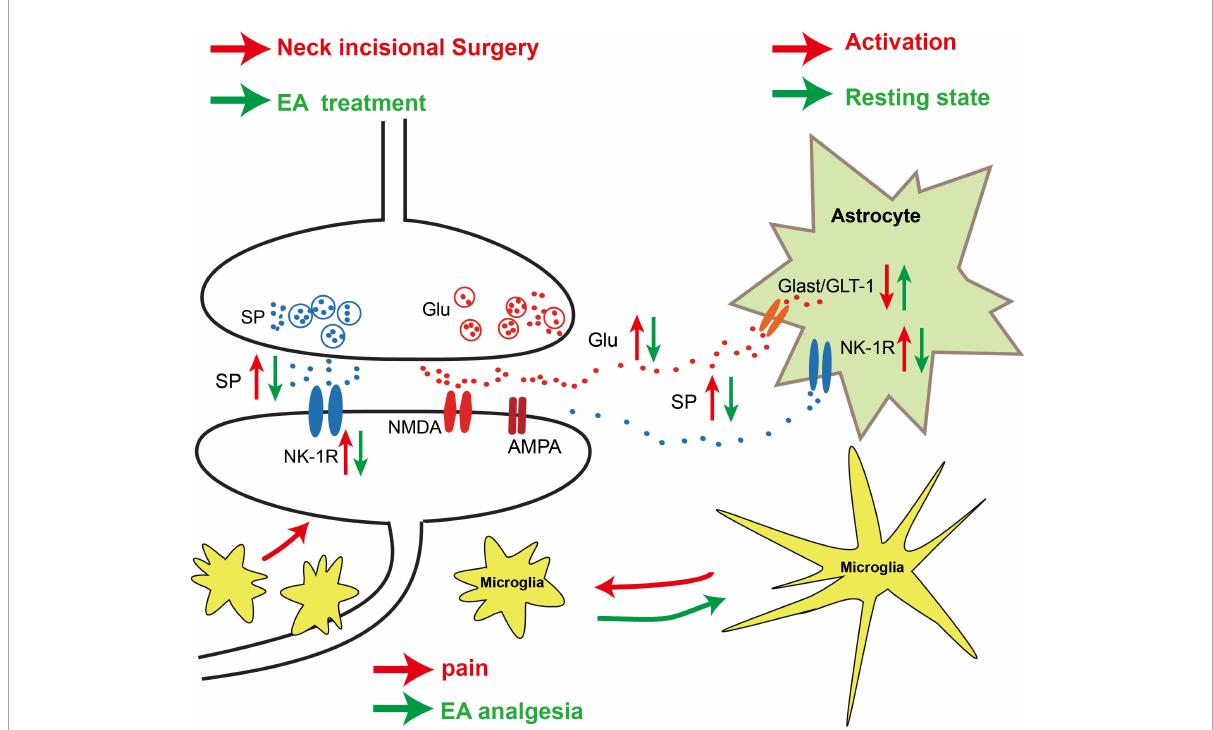
FIGURE10 Schematic diagram showing the neuronal–glial mechanism of electroacupuncture (EA) analgesia in DHs of the cervical spinal cord in rats with incisional neck pain. Following neck incision, more substance P (SP) and glutamate (Glu) were released from the presynaptic terminals of the activated primary afferent nerve fibers in the superficial layers, and more neurokinin-1 receptor (NK-1R) was expressed on the post-synaptic membrane of the neurons and astrocytes. The expression levels of glu aspartate transporter (GLAST)/glu transporter-1 (GLT-1) on astrocytes were decreased, and more extracellular Glu acted on N -methyl- D -aspartate (NMDA)/amino-3-hydroxy-5-methyl-4-isoxazolepropionic acid (AMPA) of the post-synaptic neurons after neck incision. Those led to an activation of NK-1R-positive neurons and glial fibrillary acidic protein (GFAP)-labeled astrocytes and ionized calcium-binding adapter molecule 1 (Iba-1)-labeled microgliacytes. The activated microgliacytes gathered around the NK-1R-positive neurons. These activated neurons and glial cells may contribute to the formation of hyperalgesia. EA stimulation upregulated the expression of GLAST/GLT-1 on astrocytes and downregulated the expression of NK-1R on neurons and astrocytes, to reduce the extracellular Glu level and the transmission of injury information to the post-synaptic neurons. The microgliacytes and astrocytes returned to the resting state, and the aggregation of microgliacytes around the NK-1R-positive neurons was also alleviated after EA treatment. These changes between glial cells and neurons may be one of the mechanisms of EA